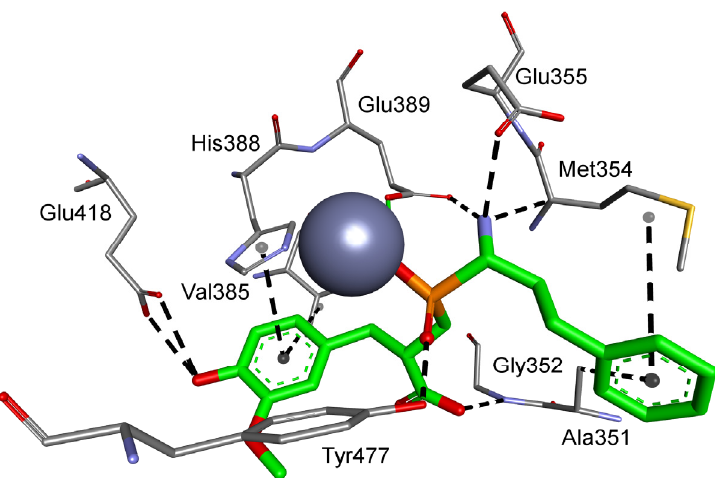
Figure 3. Modeled binding mode of the phosphinic dipeptide analog containing a 4-hydroxy-3-methoxyphenyl P1 ′ fragment in the active center of human aminopeptidase N (Protein Data Bank (PDB): 4FYT). Amino acid residues of the inhibitor and enzyme are shown as sticks, while zinc ions are shown as gray spheres. Hydrogen bonds and nonpolar interactions are shown as thin dashed lines.